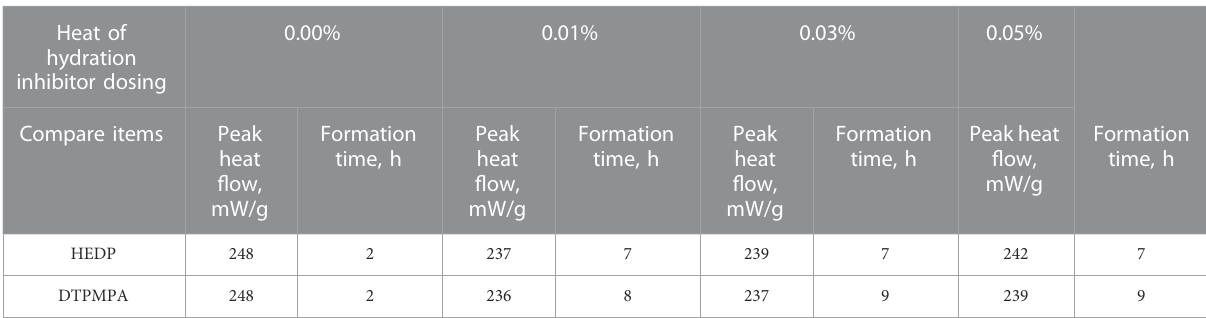
TABLE 7 Hydration reaction release rate of C 3